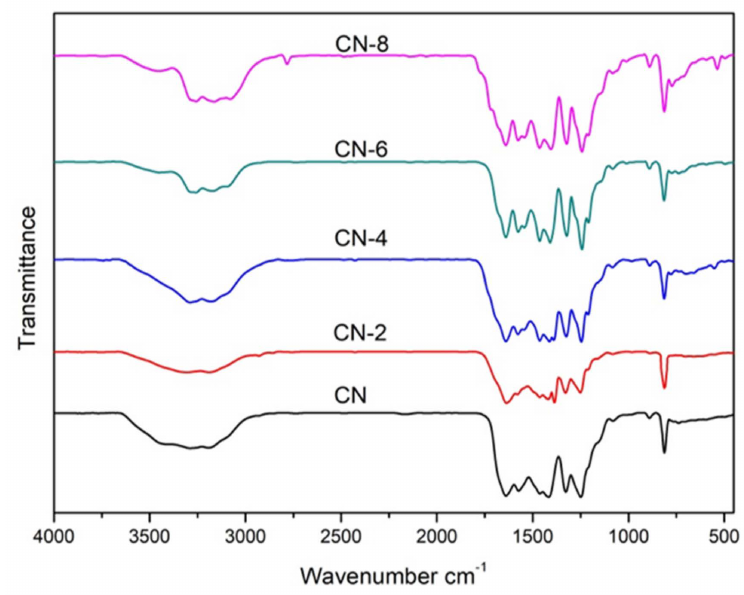
Figure 3. FT-IR spectra of